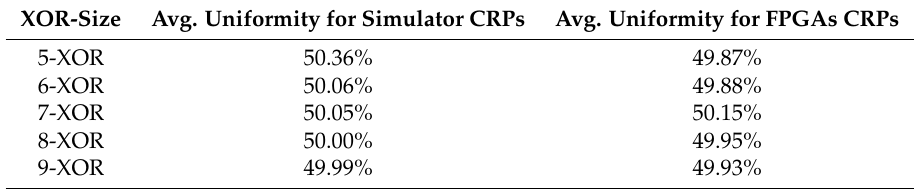
Table 2. Average uniformity of the training datasets samples. The ideal rate of the uniformity is 50%, where it indicates a 50% of 0’s and 1’s in a